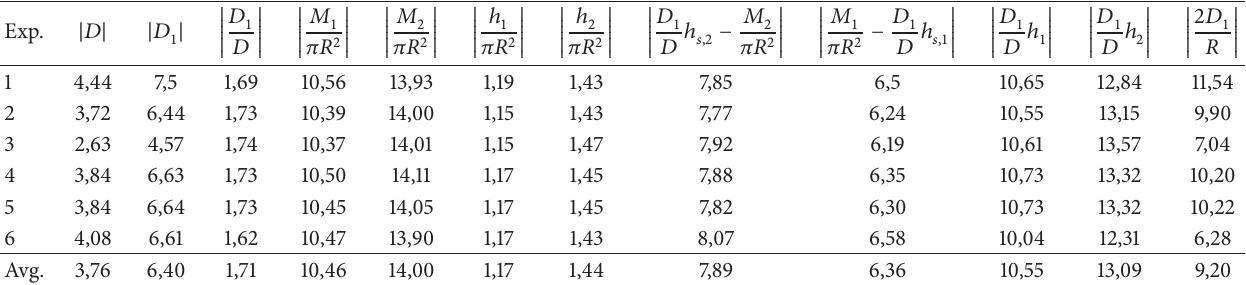
Table 2: Coefficient values of the absolute inaccuracies Δ𝑀 1 ,Δ𝑀 2 , Δℎ 1 , Δℎ 2 , Δℎ 𝑠,1 ,Δℎ 𝑠,2 , Δ𝑅 . Exp.